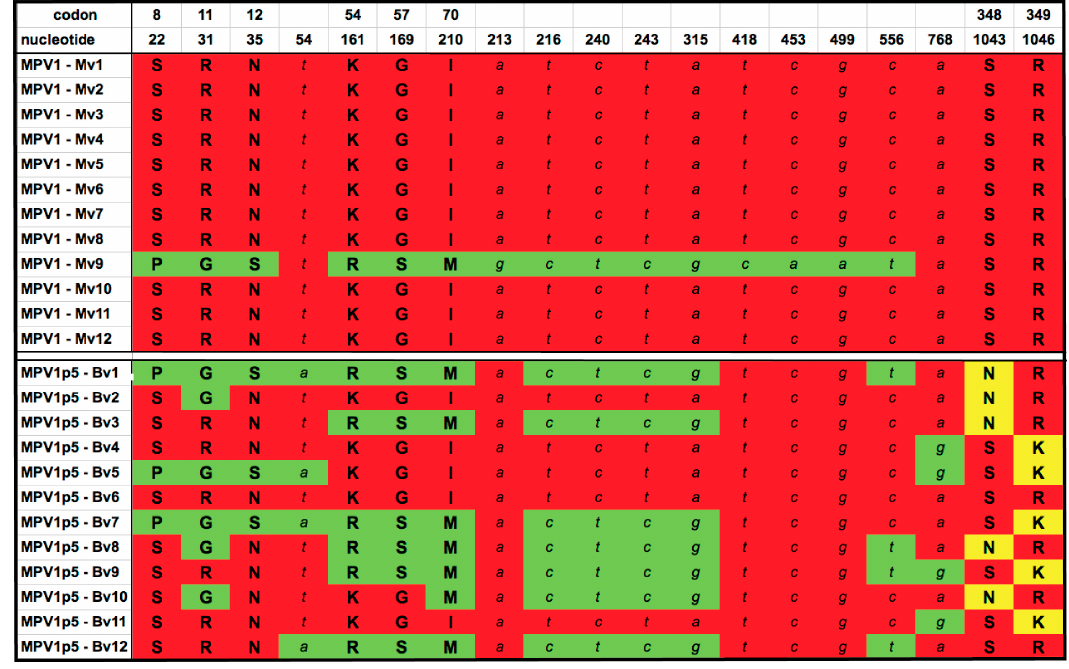
Figure 2. Analysis of mutations found in the VP2 region. Twelve clones from the MPV1 starter pool and twelve clones from MPV1p5 were sequenced and compared to one another. Synonymous nucleotide differences are indicated in italicized lower case, while nucleotide changes that resulted in amino acid substitutions are denoted by the single-letter amino acid code for the encoded residue in upper case bold. Both synonymous and non-synonymous mutations found in more than one PCR clone are included. Clones are named for the originating virus stock, “M” for parental and “B” for B16F10-passaged virus, and “v” for the VP2 region, followed by the sample number. Red and green shading denote sequences conforming to the predominant sequences of MPV1 parental and MPV1p5 VP2 genes, respectively. The two mutant residues that are unique to MPV1p5 VP2 clones are shaded in yellow.